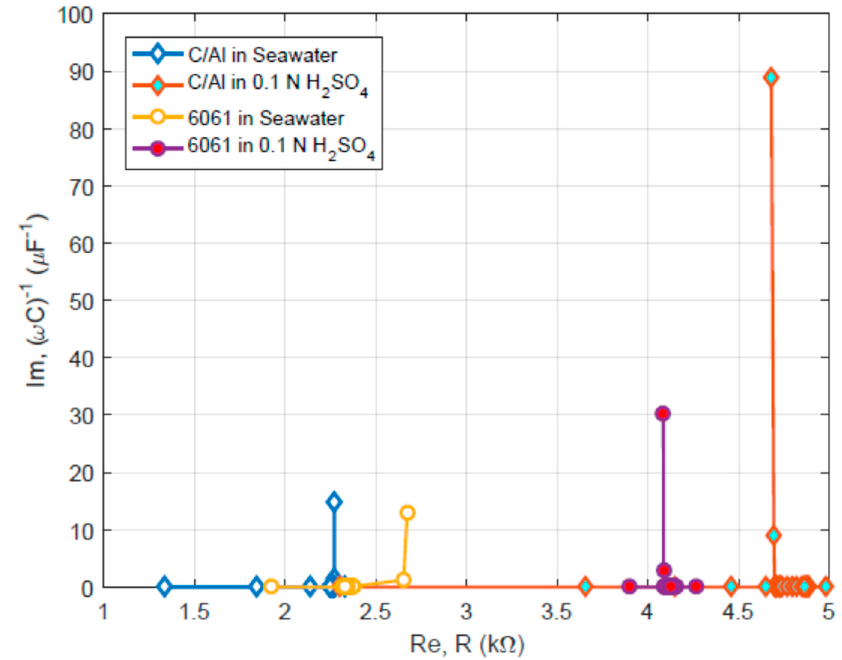
Figure 8. The impedance plots based on the EIS tests on the C/Al composite and 6061 aluminum alloy in sulfuric acid and seawater showing the pure capacitive coating behavior. in sulfuric acid and seawater showing the pure capacitive coating